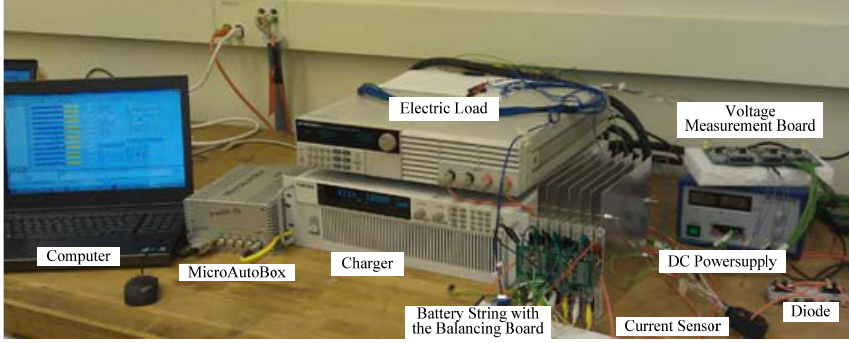
Figure 10. The Experimental Battery Test